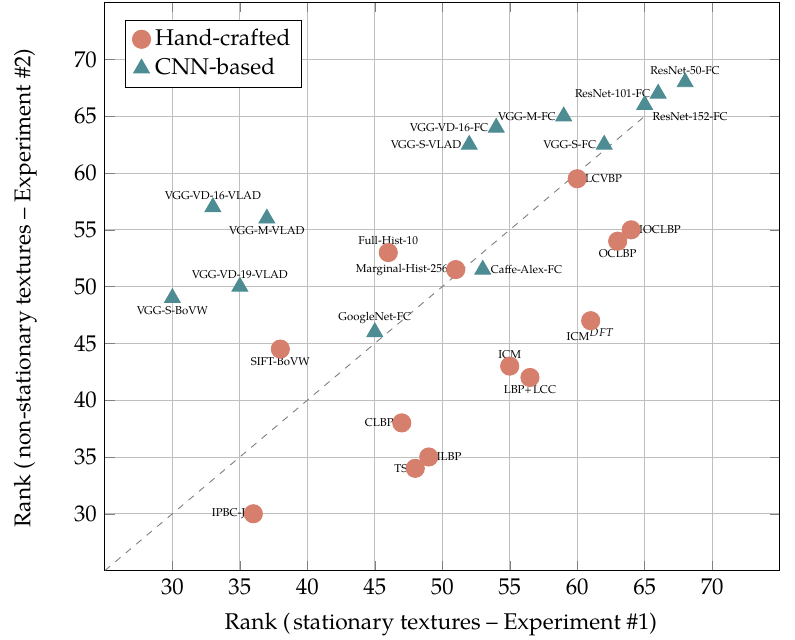
Figure 13. Relative performance of hand-crafted descriptors vs. CNN-based features with stationary ( x axis) and non-stationary textures ( y axis) under invariable imaging conditions (Experiments #1 and #2, best 13 methods). The plot shows a clear divide between CNN-based methods (mostly clustered in the upper-left part, therefore showing affinity for non-stationary textures) and hand-crafted descriptors (mostly clustered in the lower-right part, therefore showing affinity for stationary